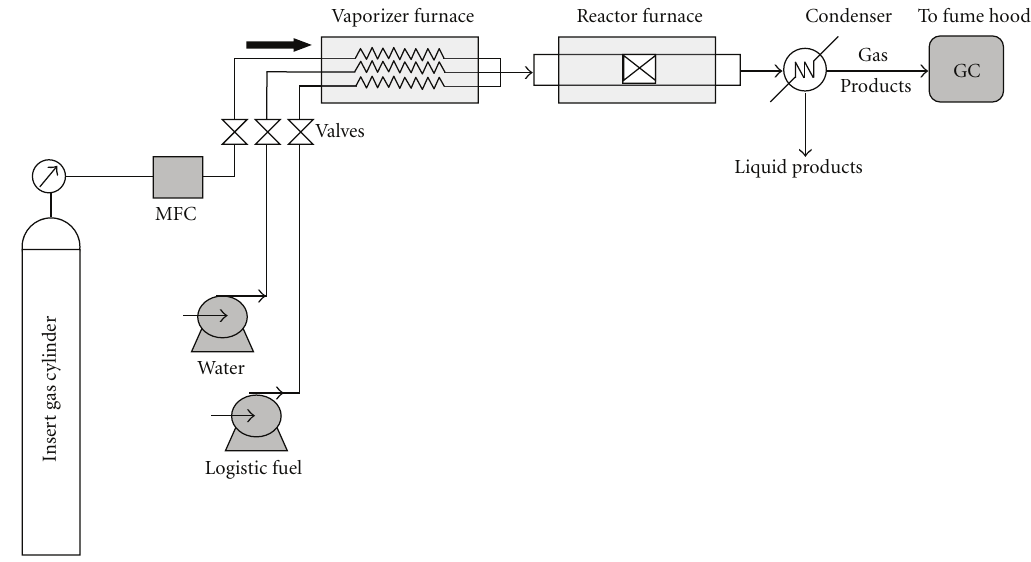
Figure 1: Schematic of the set-up for reforming